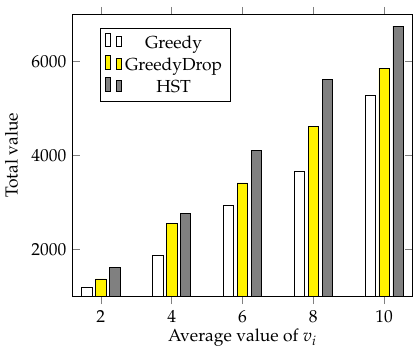
Figure 13. The effect of different average value of fading factors for non-FIFO